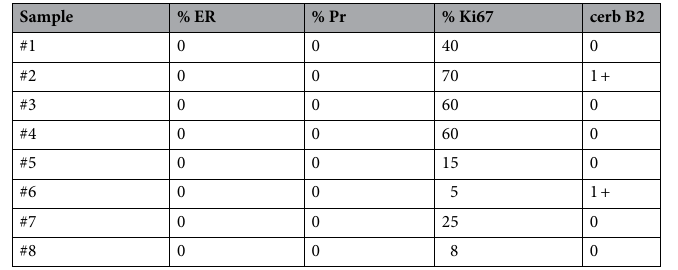
Table 2. Immunohistochemical characterization of TNBC human samples.